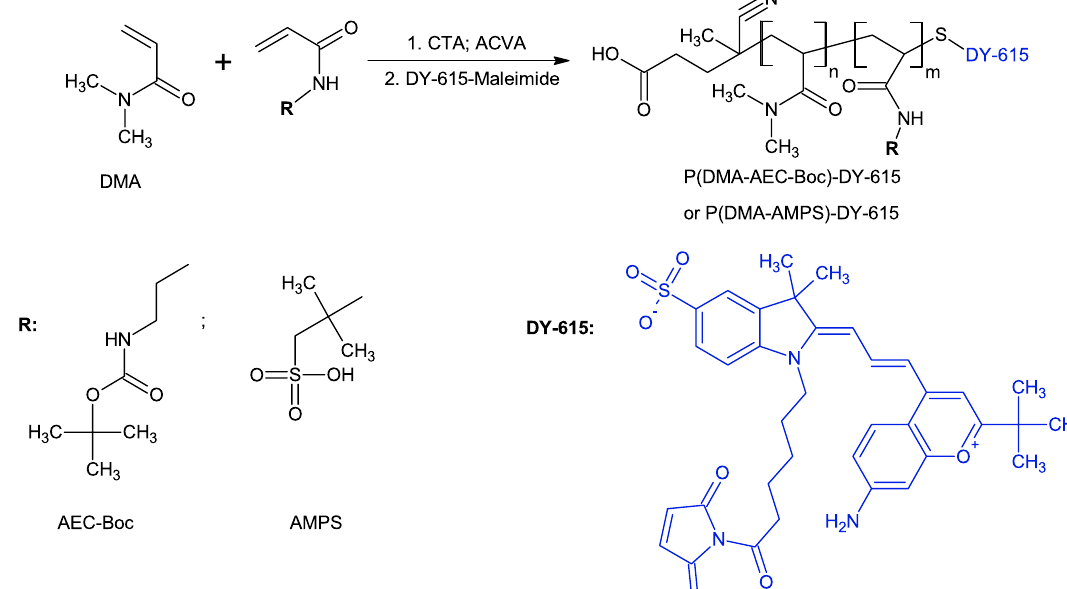
Figure 1. Copolymerization of N,N -dimethylacrylamide (DMA) with tert -butyl[2-(acryloylamino)ethyl] carbamate (AEC-Boc) or 2-(acryloylamino)-2-methylpropane-1-sulfonic acid (AMPS) and labeling with